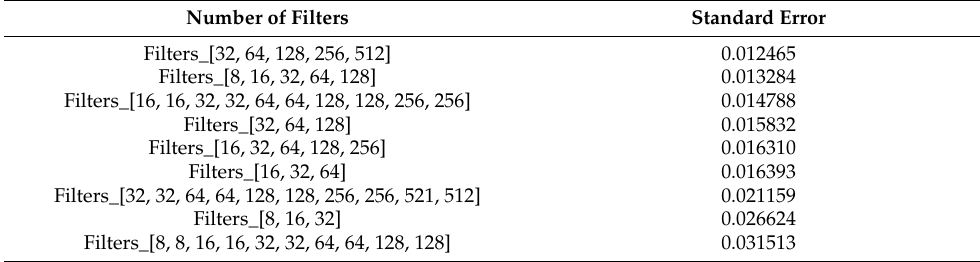
Figure 3. Selected parameters (the number of filters) for U-net architecture. Table 1. The standard error of the test